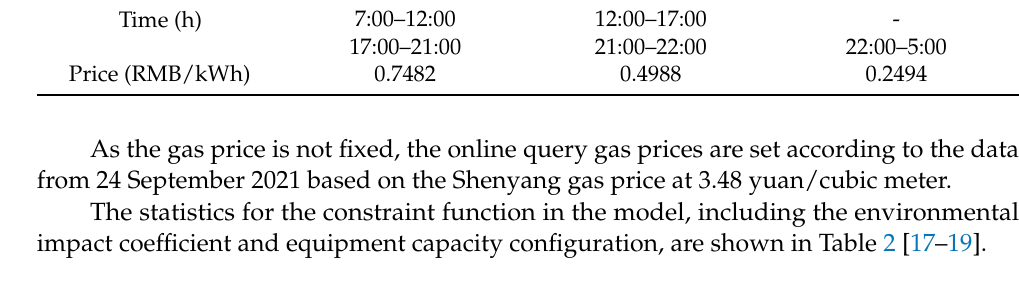
Table 2. Power generation unit environmental impact parameter